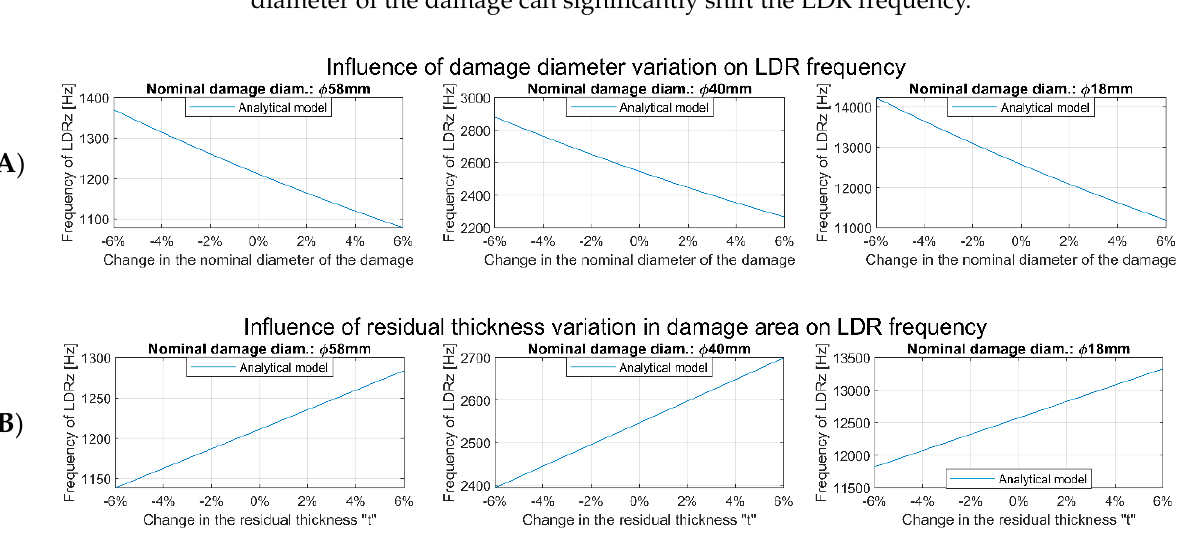
Figure 4. Influence of damage diameter ( A ) and residual thickness ( B ) variation on theoretical LDR frequencies calculations made for the design values of FBH dimensions.